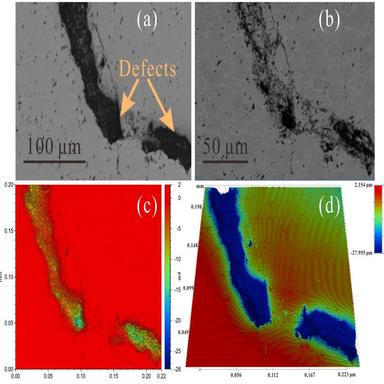
The original position HTC method for defects in TC4 titanium alloy: (a) surface profile image of defects presented by OM in 2D characterization methods; (b) surface profile BSE image of defects presented by HTSEM in 2D characterization methods; (c) 2D contour map of surface profile presented by WLI in 3D characterization methods for defects, with corresponding 3D surface profile morphology as (d).